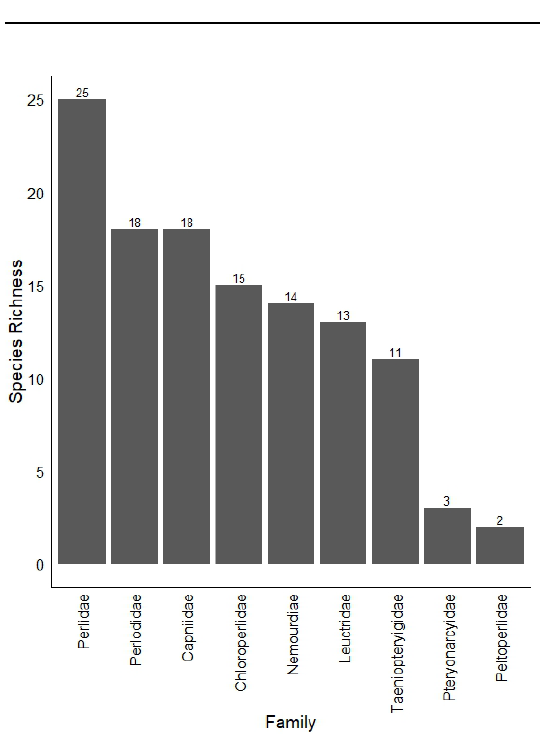
Figure 2. Species richness for United States Geological Survey Hydrologic Unit Code (HUC)-10 catchments of Maryland with georeferenced collection locations.